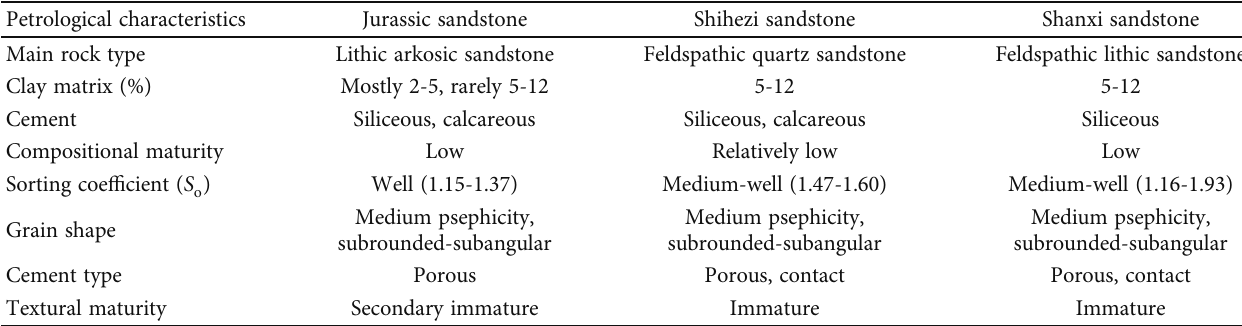
Figure 3: The original samples were divided into four groups to carry out various laboratory tests. (a) Height 25.4-50.8mm and diameter 25.4mm for the porosity and permeability tests. (b) Casting thin sections for the Zeiss Imaging-2M polarizing microscope observations. (c) Height 6 mm and diameter 4 mm for the SEM observations. (d) Crushing, grinding, and removing cement with hydrochloric acid and drying for the grain sizes analysis. Table 1: The petrological characteristics of deep mine sandstone.